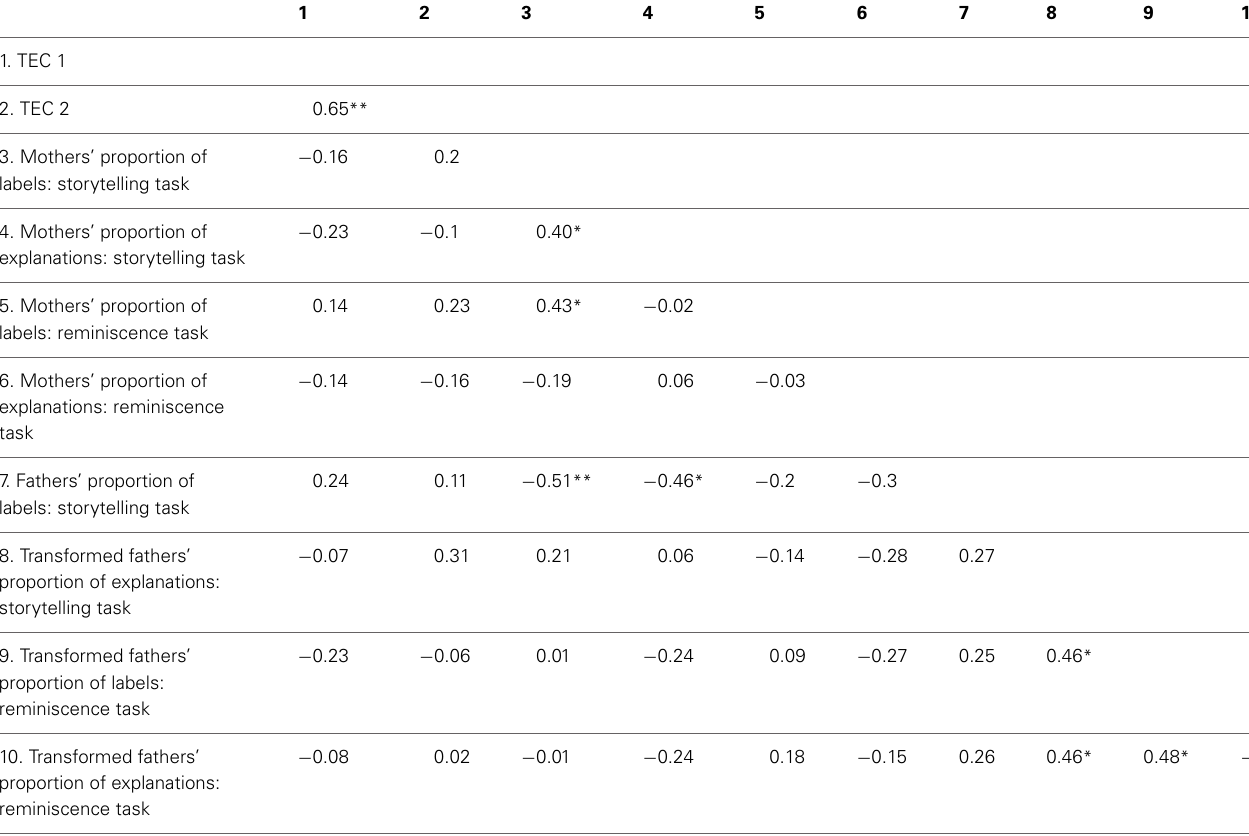
Table 3 | Relations between parental emotion talk and children’s emotion understanding at age 6.